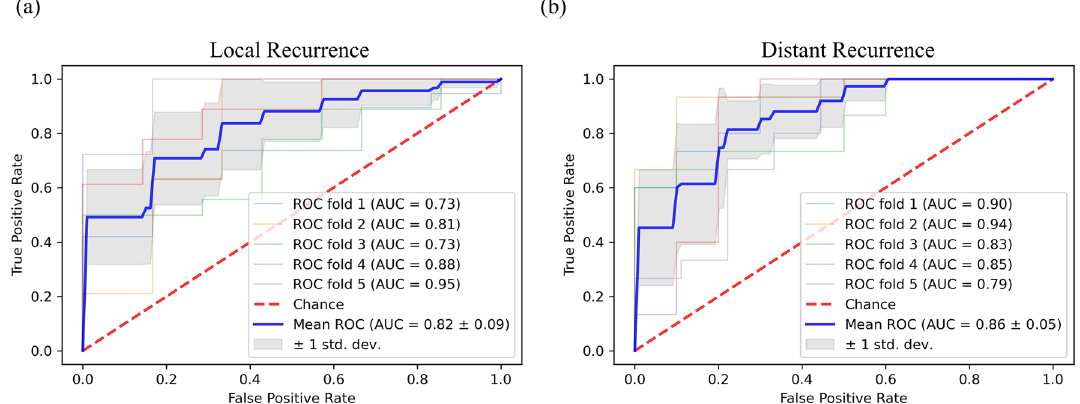
Figure 3. Receiver operating characteristics (ROC) curves of prediction models for recurrence patterns with fivefold cross validation for ( a ) local recurrence, and ( b ) distant recurrence.